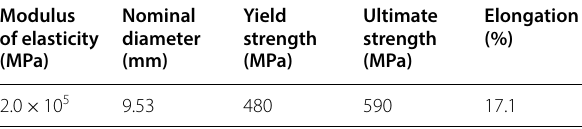
Table 4 Mechanical properties of the steel rebar used.